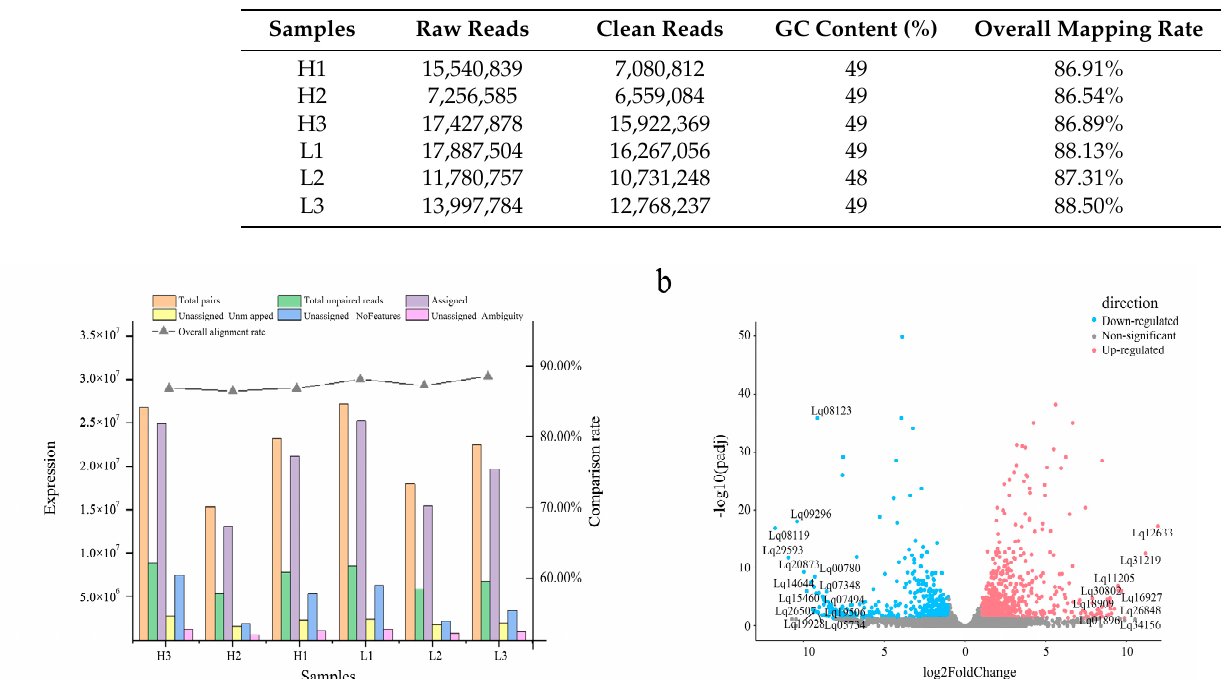
Figure 2. Gene expression quantification and differentially expressed gene (DEG) identification in the transcriptome. ( a ) Sequence alignment and expression quantification of sequenced samples. ( b ) Differentially expressed genes. Horizontal coordinates indicate the logarithmic values of the fold difference between H and L groups, while vertical coordinates indicate the -log 10 value of the false discovery rate (FDR) of the difference between the two subgroups. Orange–red points and blue–green points indicate upregulated and downregulated expression in the H vs. L groups, respectively, while gray points indicate no significant